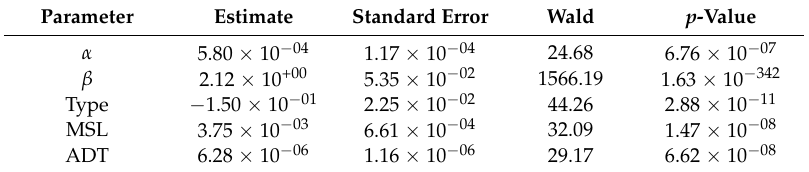
Table 5. Parameter and standard error estimates for the Hypertabastic accelerated failure time model.